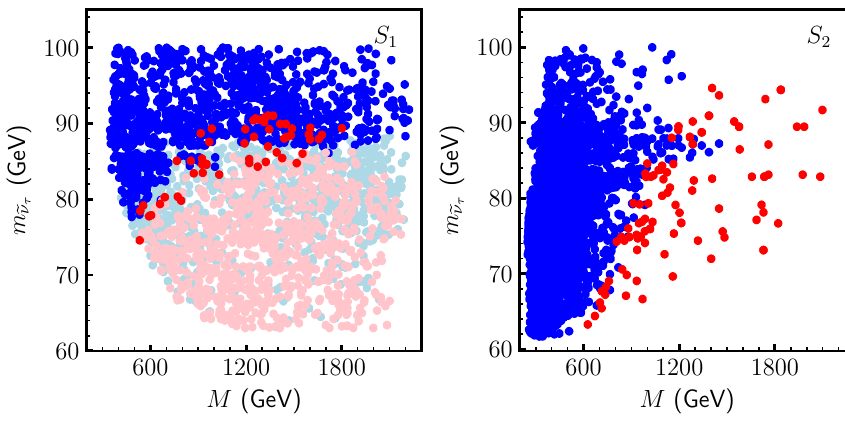
Fig. 7 Tau left sneutrino LSP mass versus M for scan S 1 (left) and scan S 2 (right). The color code is the same as in Fig.